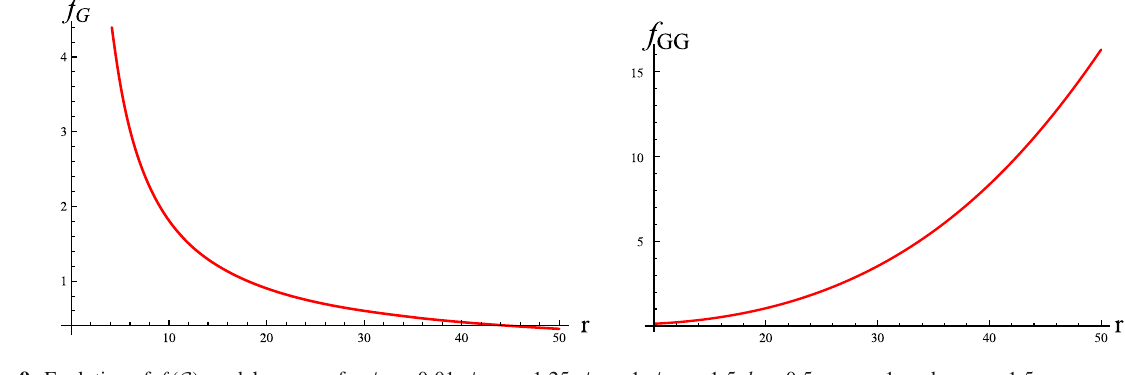
Fig. 9 Evolution of f ( G ) model versus r for φ 1 = 0 . 01, φ 7 = − 1 . 25, φ 9 = 1, φ 10 = 1 . 5, k = 0 . 5, w = − 1, and ρ 0 = − 1 . 5